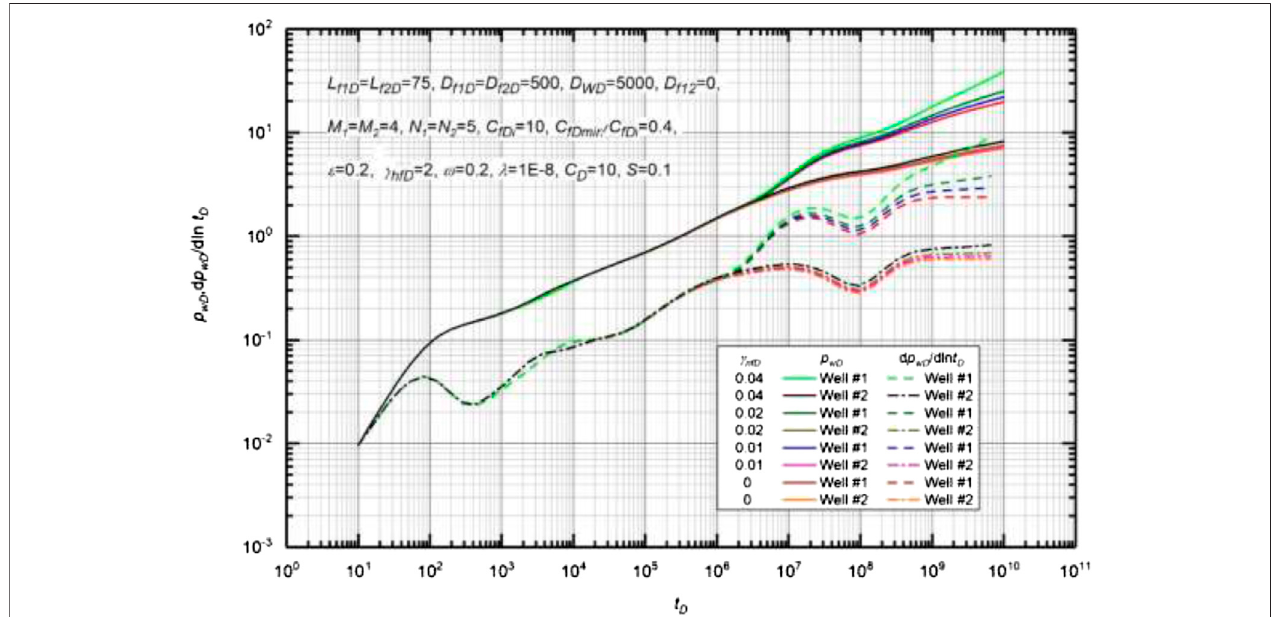
FIGURE 9 | Effect of the natural fracture permeability modulus on the transient pressure for